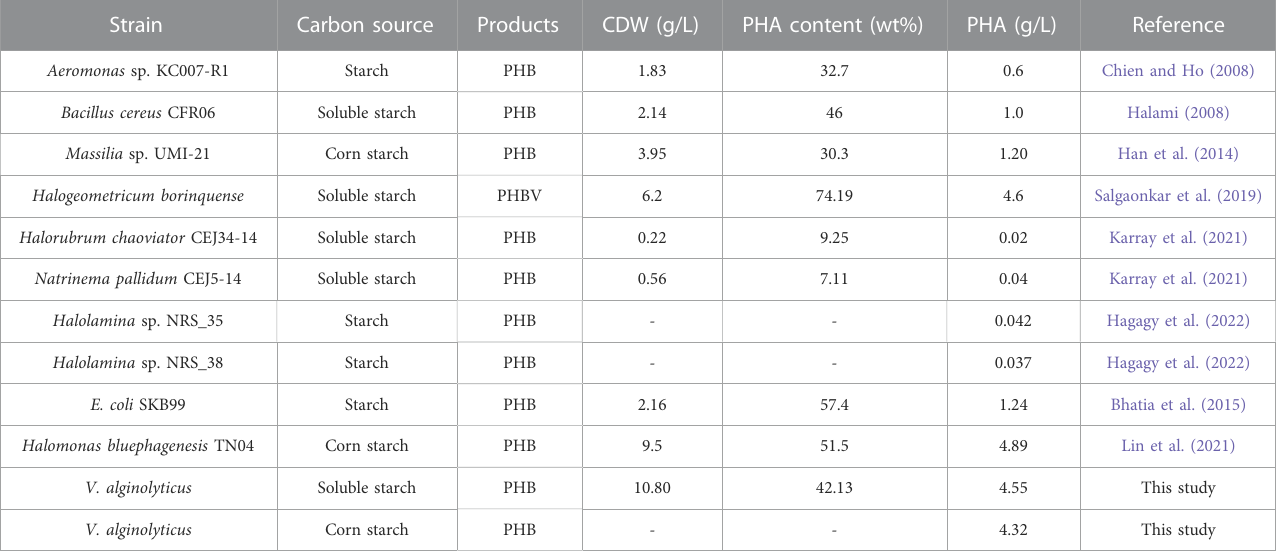
TABLE 2 PHA production by microorganisms using starch as the carbon